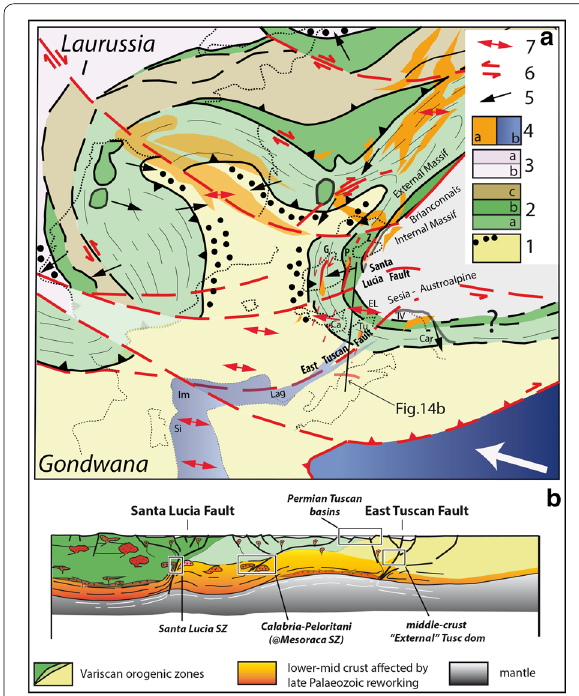
Fig. 14 Interpretative configuration of the post-Variscan setting (at c. 270 Ma) based on a modified version of Fig. 2 in Matte (2001). The scheme show a possible frame of the Variscan belt of western Europe and north Africa, with the main Upper Carboniferous-Permian regional fault systems and related continental basins (after Burg et al. 1994). The original scheme of Matte (2001) is modified taking into account the data and interpretations proposed in this work. The Santa Lucia Fault (whose remnants are documented in the lower to mid-crust shear zone in the Alpine Santa Lucia Nappe), and the East Tuscan Fault (remnants in subsurface of Pontremoli and Larderello deep well) in the Apennines are represented. The East Tuscan Fault is prolonged southwards into the Lagonegro-Imerese-Sicani marine rifted domains (Catalano et al. 1995) westernmost extension of the Permian rifted basin related with Neo-Tethys (Ziegler and Stampfli 2001; Stampfli et al. 2002; Garfunkel 2004; Xyapolis et al. 2006; Schettino and Turco 2011). (1) Gondwana and Gondwana-derived crust blocks (Apulia and Adria figured); (2) Southern Europe Variscan belt: (a) low-grade external and nappe zone dots foreland domains, (b) axial zone medium to high grade units, suture/s and Ordovician arcs, (c) hinterland and Variscan retrowedge (Armorica, Hun or Brunia terranes); (3) (a) Laurussia-derived blocks of the northern continent; (b) inner domains of the South Europe Variscan orogen; (4) Permian sedimentary basins: (a) continental, (b) marine; (5); main vergence of the nappes; (6) kinematics of late Palaeozoic regional faults; (7) extension direction during Upper Carboniferous-Permian. The possible positions of the Briançonnais, South-Alpine and Austro-Alpine domains are also reported (see also Festa et al. 2018; Ballevre et al. 2018 and references); thin dashed red lines represent dyke trend in Calabria (after Festa et al. 2010). Si: Sicani; Im: Imerese; Lag: Lagonegro; Ca: Calabria; Tu: Tuscany; Car: Carnia; IV Ivrea Zone; EL: External Ligurian; Z: Zicavo Shear Zone; P: Posada-Asinara; G: Grighini Shear Zone. (b) Conceptual schematic cross-section to envisiged the proposed tectonic scenario for late Palaeozoic in Central Mediterranean. The regional cross-section is traced not-perpendicular to the main regional fault systems to show and insert all the late Palaeozoic crustal domains and the different zones of South Europe Variscan orogen discussed in the